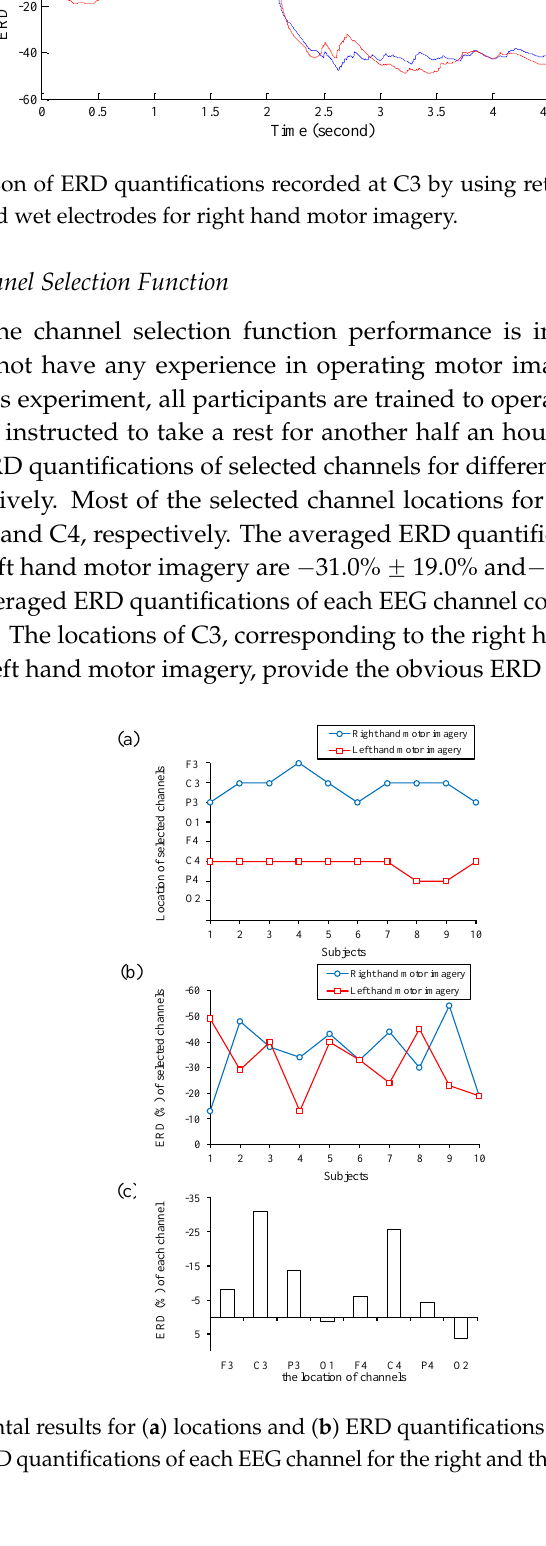
Figure 7. Comparison of ERD quantifications recorded at C3 by using retractable comb-shape dry active electrodes and wet electrodes for right hand motor imagery.